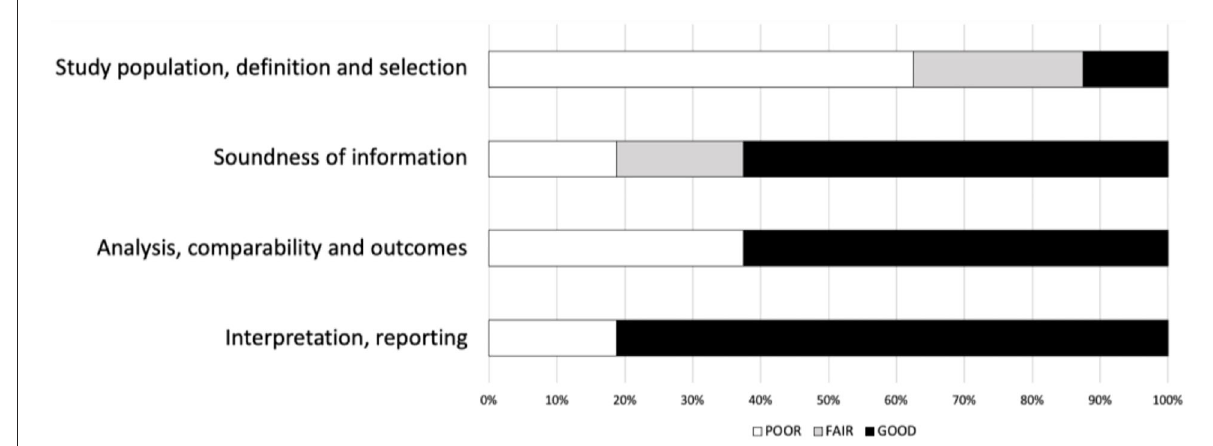
FIGURE2 Risk of study quality bias (%). National Institutes of Health (NIH) quality assessment. The NIH quality assessment tool is applicable to different study designs and examines each study’s internal validity by a set of items. For each study design, we subsequently regrouped items on four domains: “study population, definition, and selection,” “soundness of information,” “analysis, comparability, and outcomes,” and “interpretation and reporting.” A “poor” rating denotes that none of the items within the domain for the respective study design had an affirmative score; a